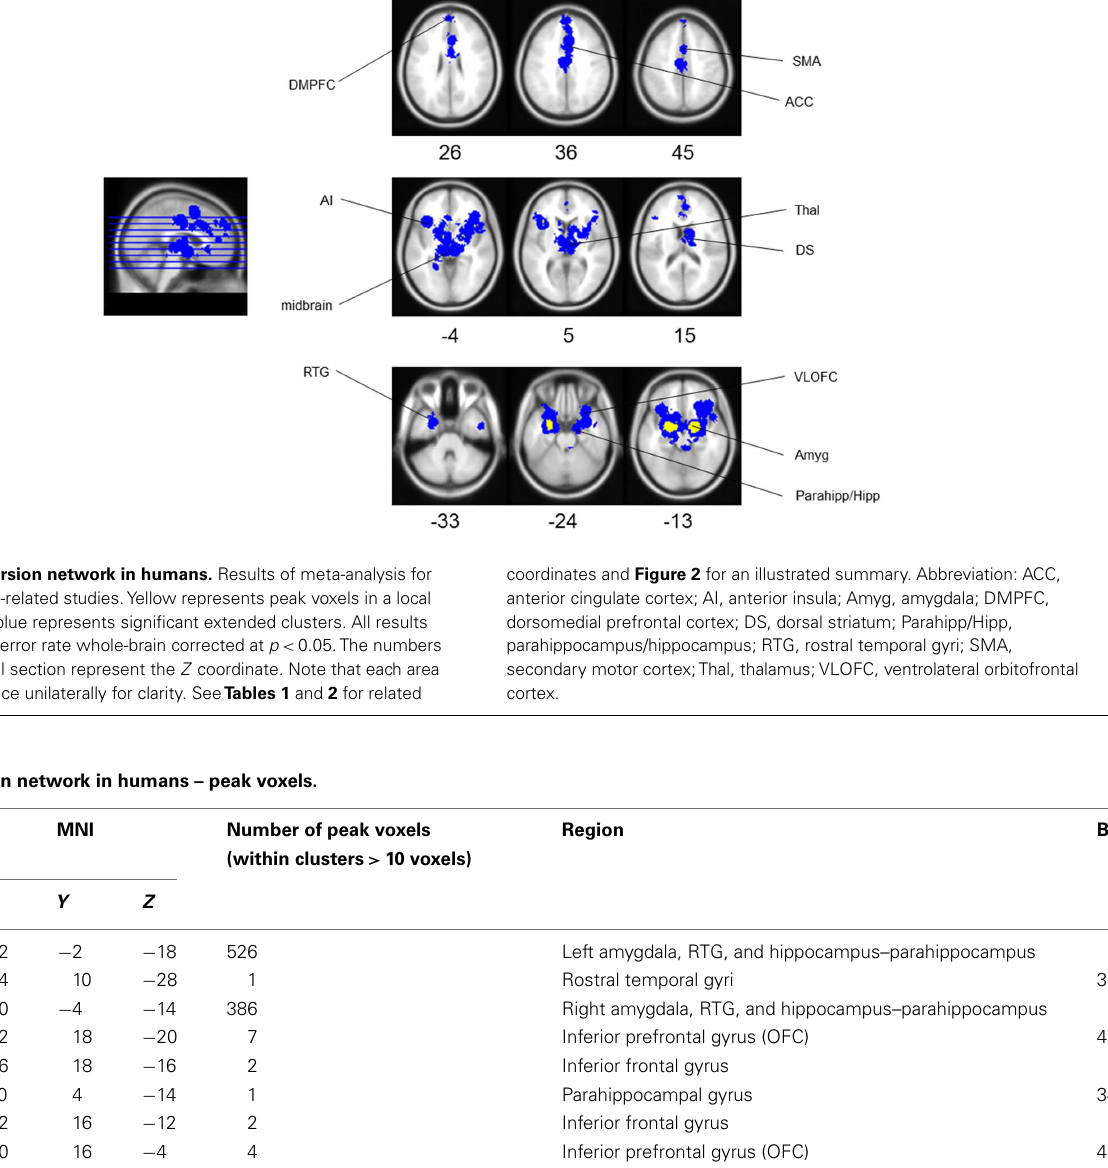
Table 1 |Aversion network in humans – peak